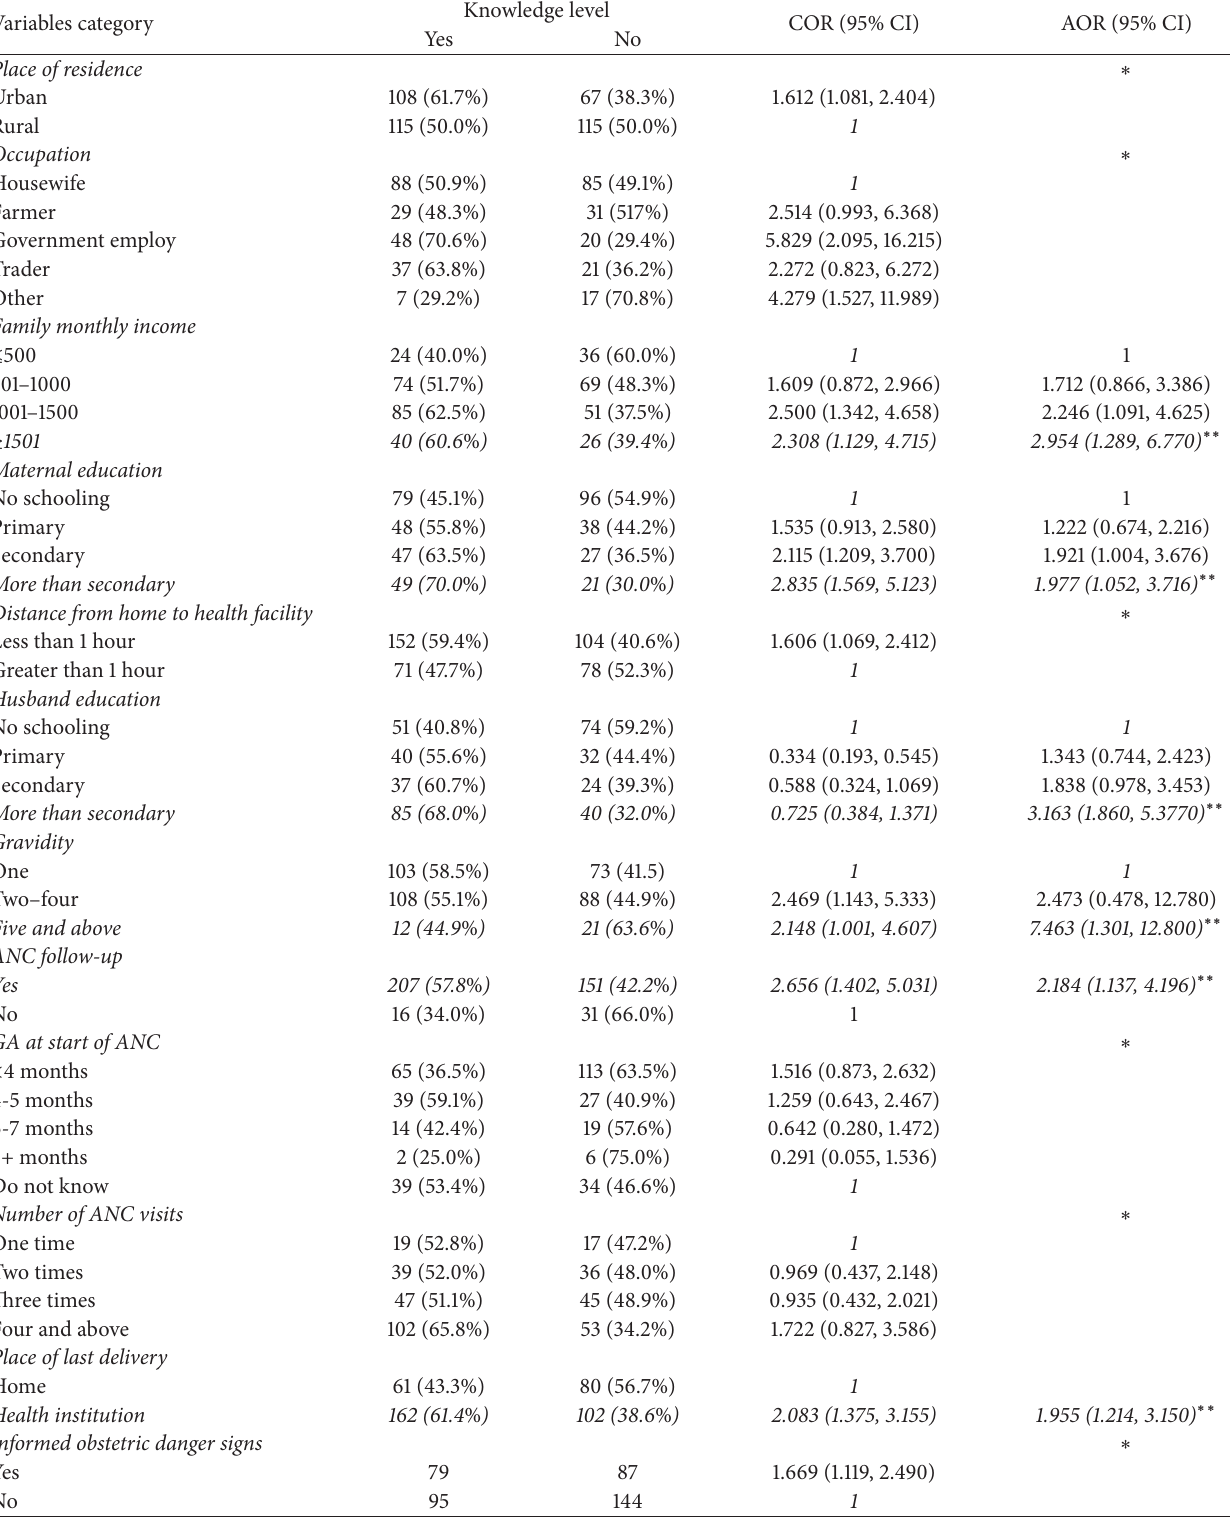
Table 4: Bivariate and multivariate analysis of factors associated with knowledge about danger sign of obstetric complications